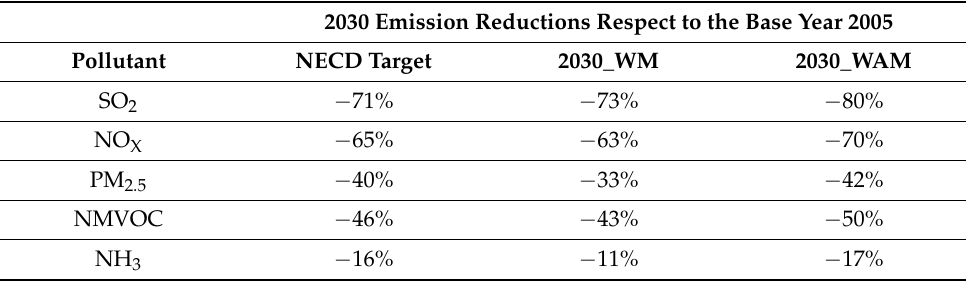
Table 7. Verification of fulfilment of emission reduction targets set by the NECD for the year